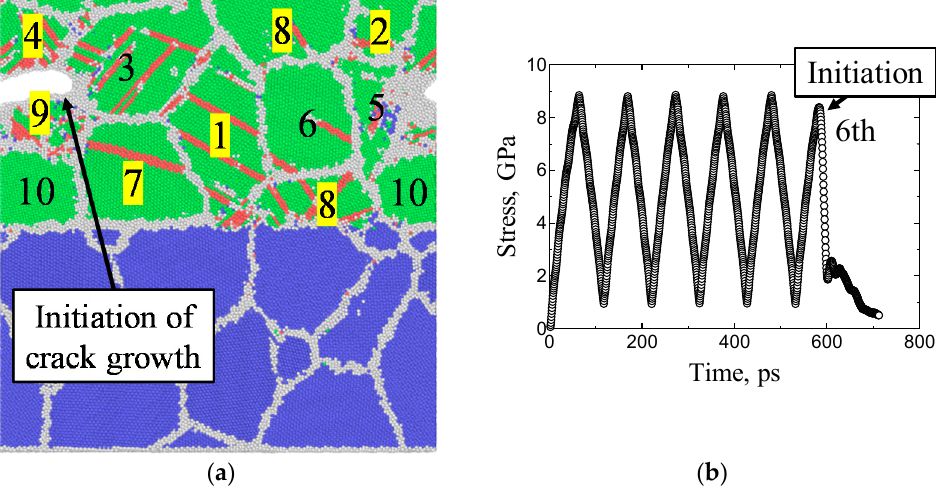
Figure 15. Snapshot at the time of fatigue crack initiation ( a ) and transition of stress during cyclic loading ( b ) when a maximum tensile stress of 8.80 GPa was applied to Model 1.